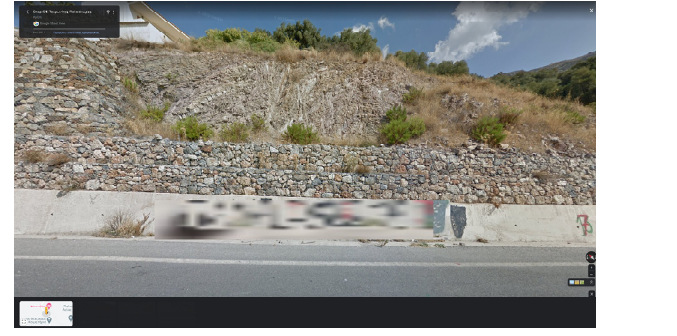
Figure 5. Identification of potential ongoing landslide events in the entrance of the Macheri village [36].